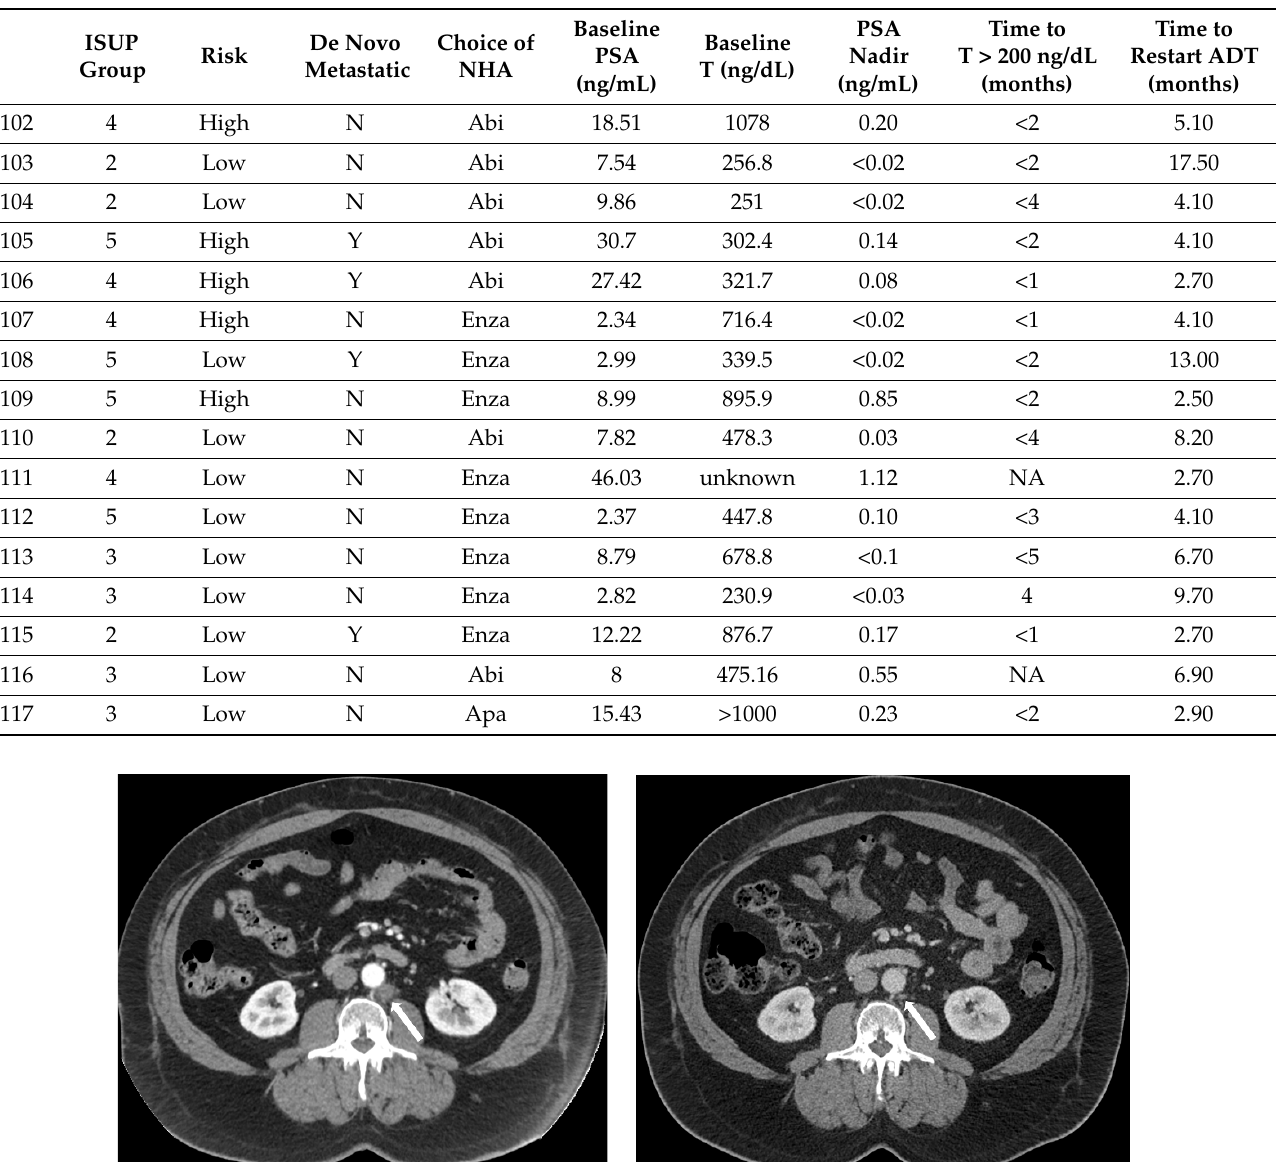
Table 2. Breakdown of each patient’s risk factors, response to induction ADT, testosterone (T) recovery time and the length of first treatment break/time to restart ADT. ISUP, International Society